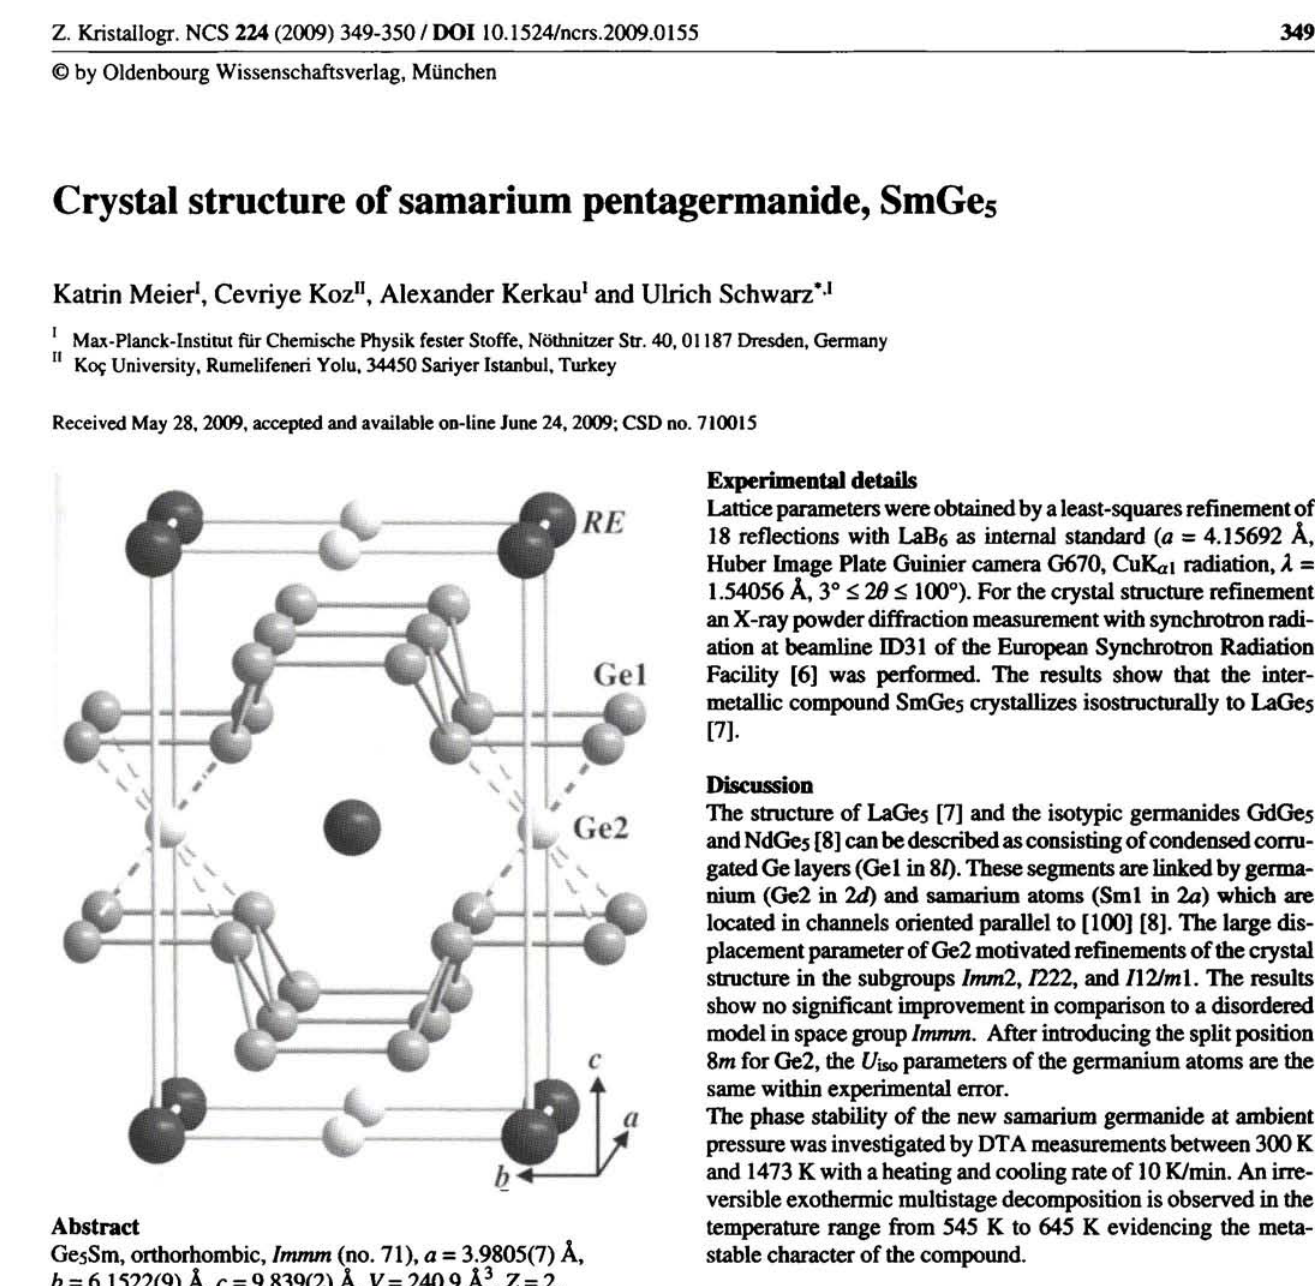
Table 1. Data collection and handling.